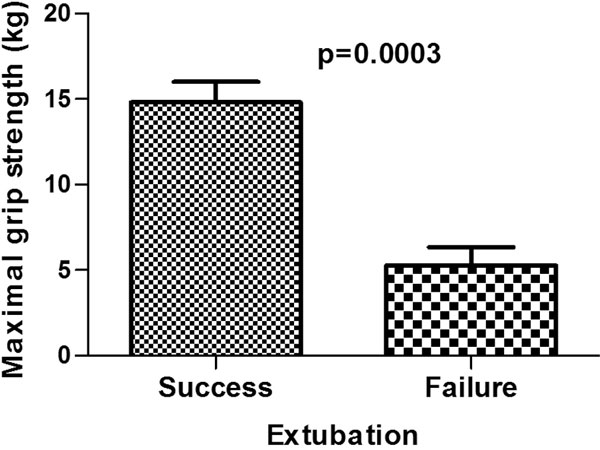
Difference between maximal grip forces.